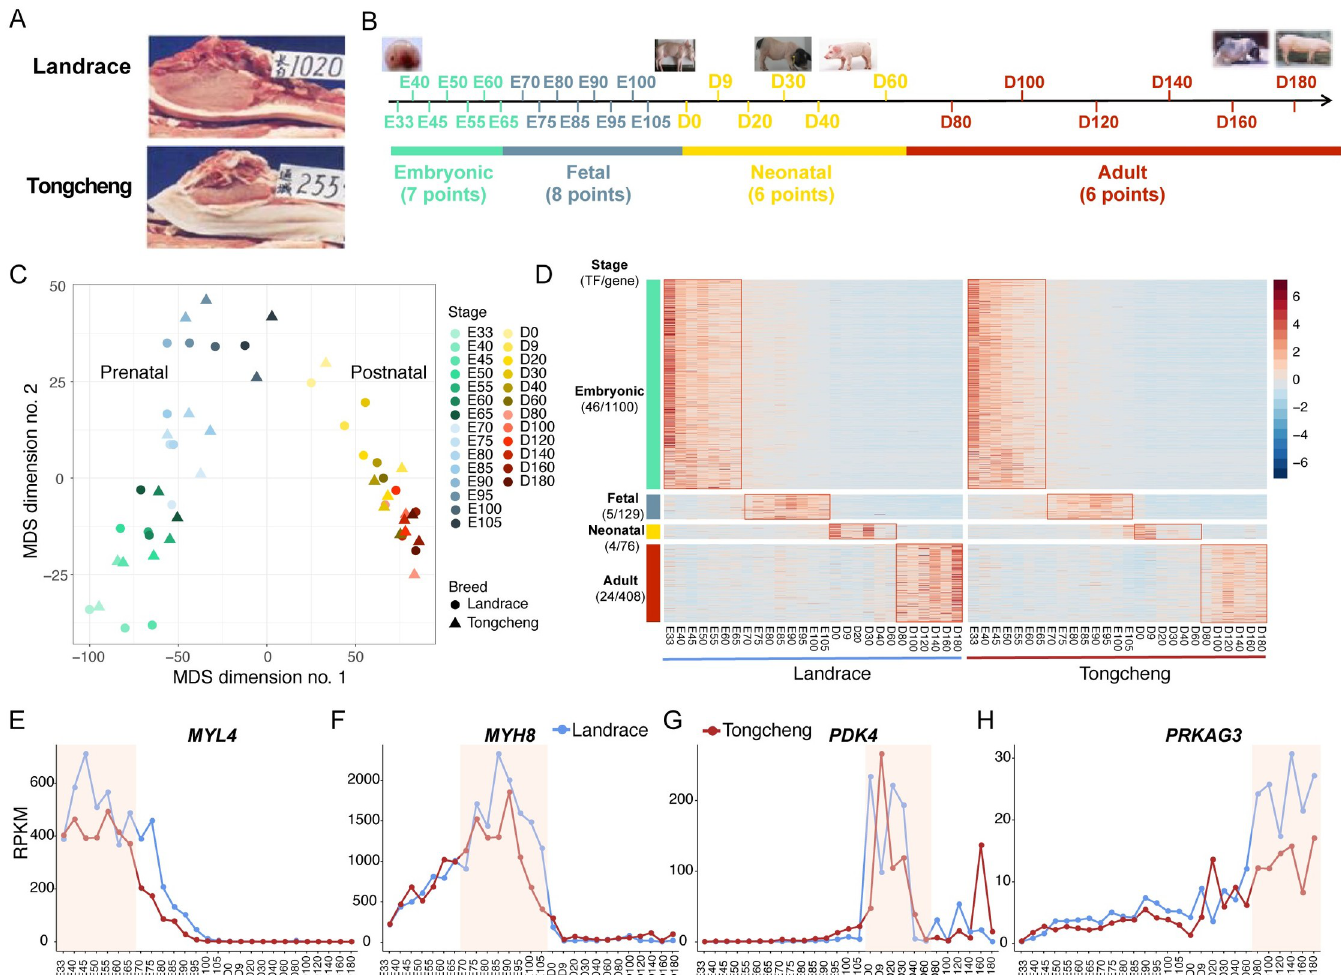
Fig 1. Global view of the pig skeletal muscle transcriptome. ( A ) The cross section of longissimus dorsi and subcutaneous fat between the 6th and 7th ribs in 10-month- old Landrace and Tongcheng pigs. ( B ) Skeletal muscle sample collections from Landrace and Tongcheng pigs at 27 developmental time points (E33 to D180) collected for RNA-seq and miRNA-seq analysis. E, embryonic days, D, postnatal days. ( C ) Multidimensional scaling (MDS) plot showing similarities and differences in genome- wide expression profiles among skeletal muscle samples from Landrace and Tongcheng pigs. MDS was performed on data from all expressed genes to represent each sample as a single point colored by the developmental period. The Euclidean distance of log2-transformed RPKM values was used to measure pairwise similarity. ( D ) Relative expression pattern of phase-specific expressed genes in the embryonic, fetal, neonatal, and adult periods. ( E ) The expression of representative phase-specific genes ( MYL4 , MYH8 , PDK4 , and PRKAG3 ) during skeletal muscle development.